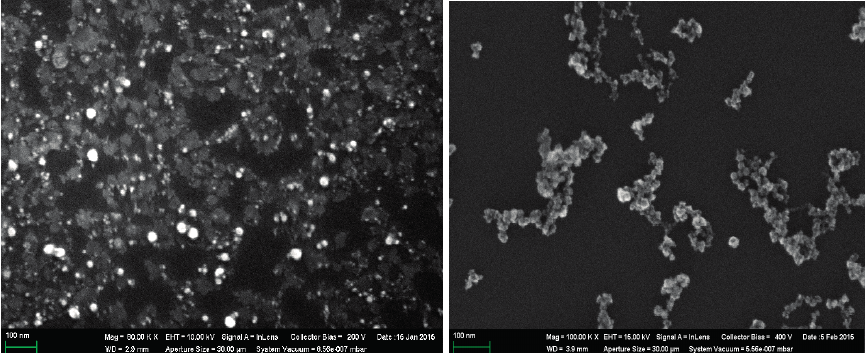
Figure 8. SEM images of NiO ( left ) and Mn 3 O 4 ( right ) nanoparticles in suspension obtained by scanning electron microscopy.